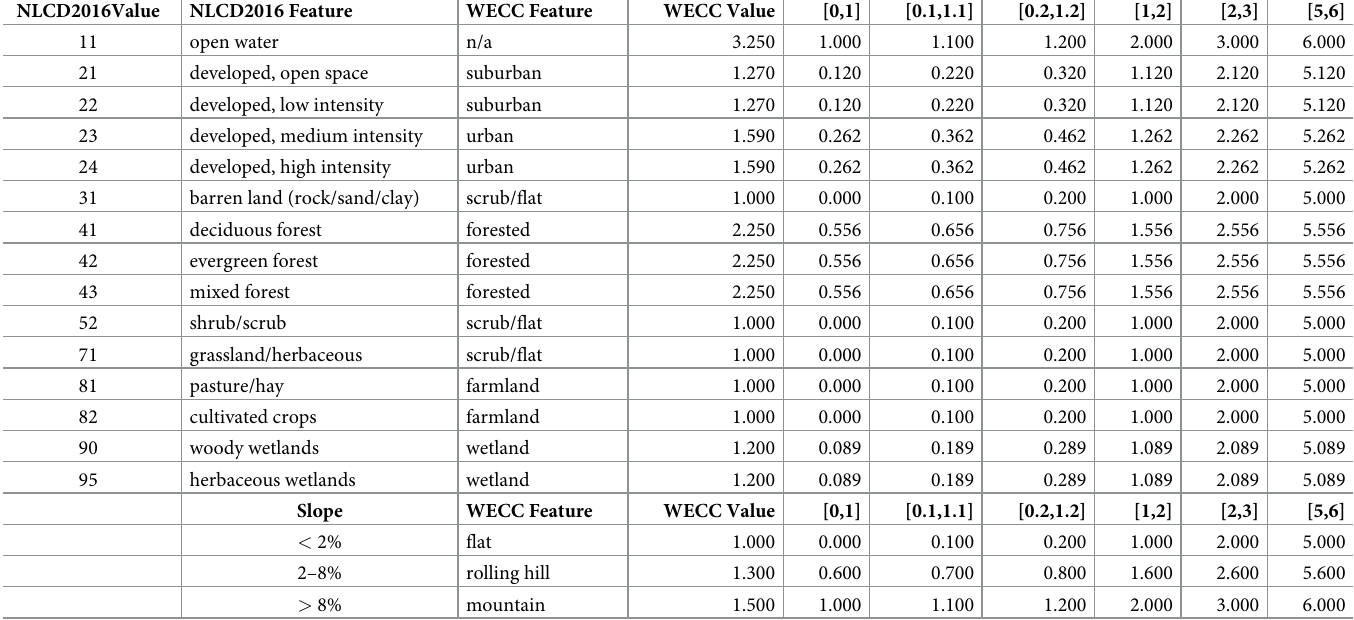
Table 2. Attribute reclassification for fixed amplitude and varying C min